Question: What direction does the quantity move in — increasing or decreasing?
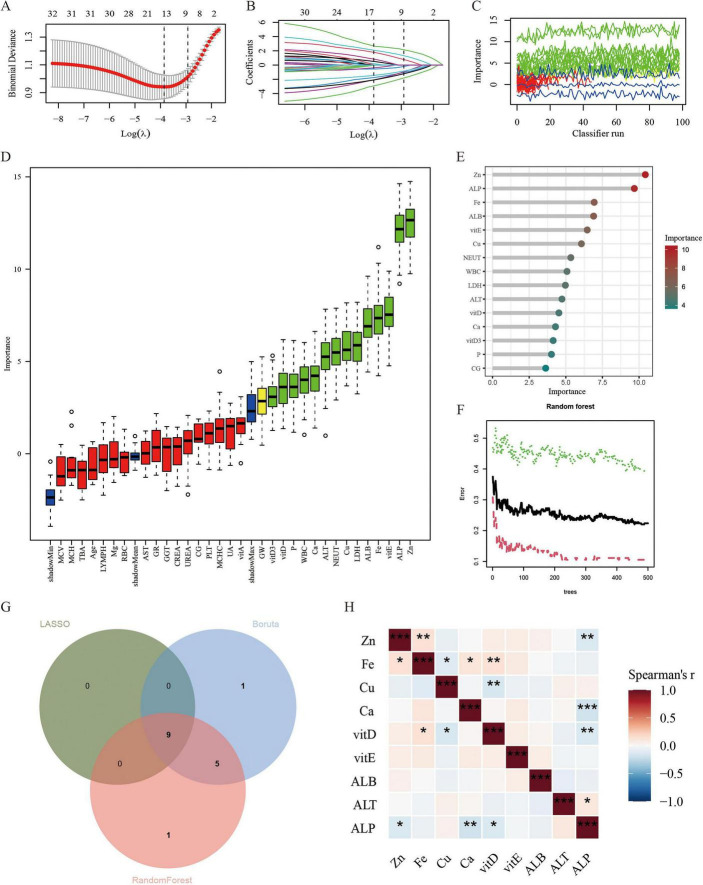
Answer: increasing